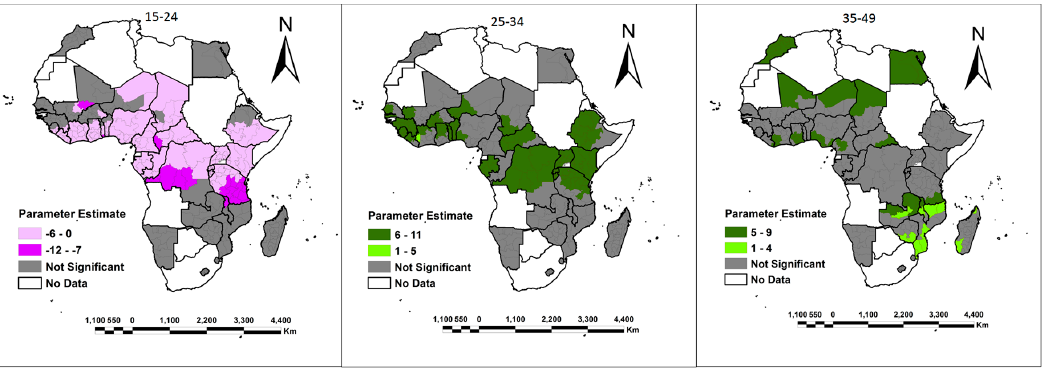
Figure 8. Spatial distribution and significance of age on women’s access to family land.